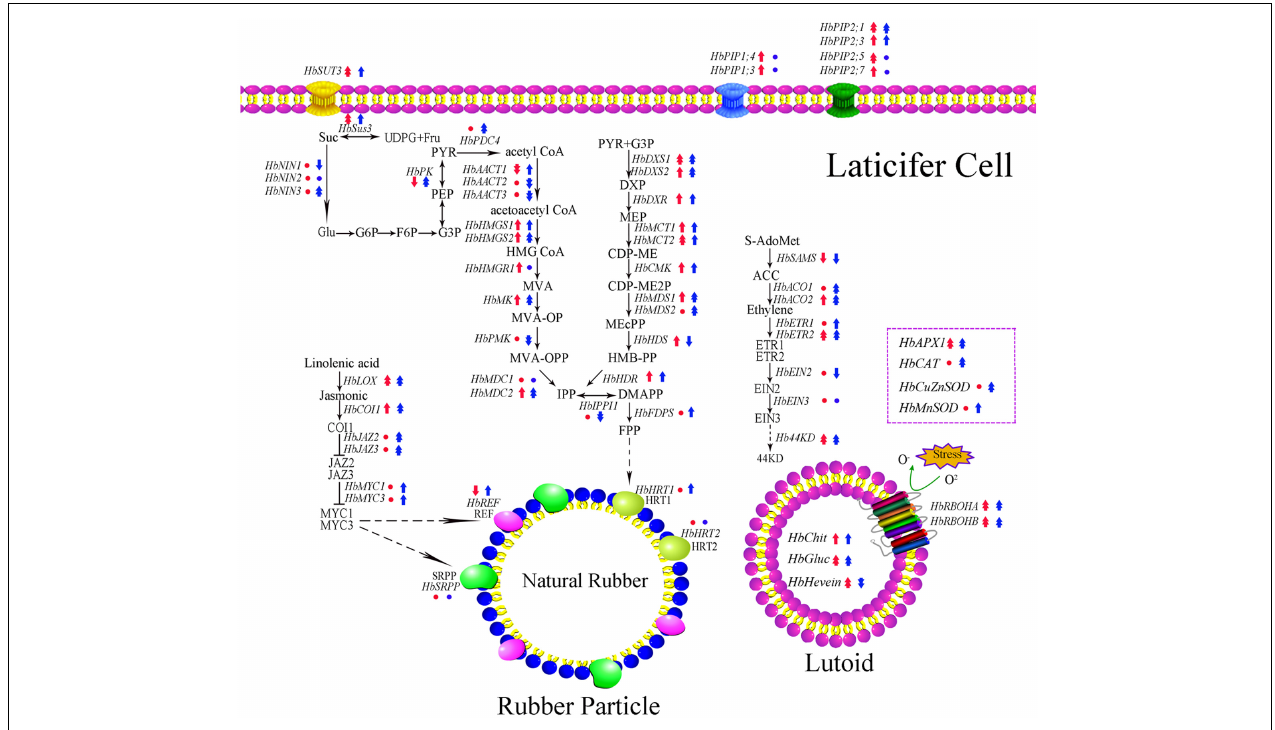
FIGURE 8 | Schematic representation of expression pattern of latex metabolism-related genes in laticifer cell. The genes expression pattern in early or late stage of latex flow between two clones is obtained by CATAS7-33-97 versus CATAS8-79. Red represented early stage of latex flow while blue represented late stage of latex flow. Circle, single arrow, double arrow represented no change, 0.05, 0.01 significant difference. Up-regulation showed high expression in CATAS8-79 and down-regulation showed high expression in